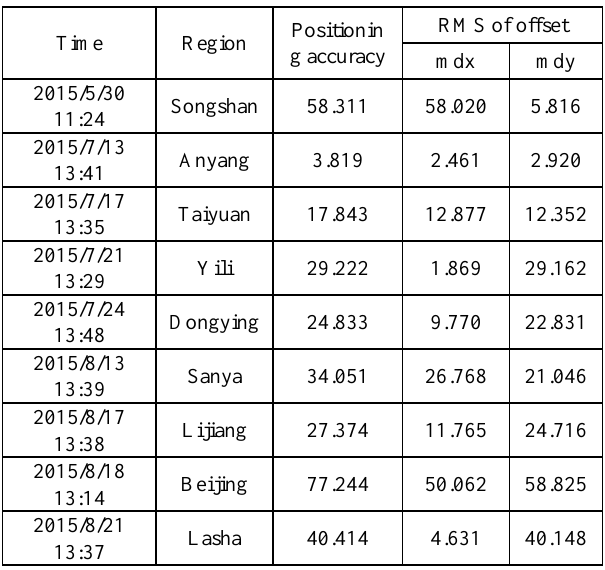
Table 2. Tables of geometric accuracy of panchromatic image when low frequency error compensation model is added (Unit: